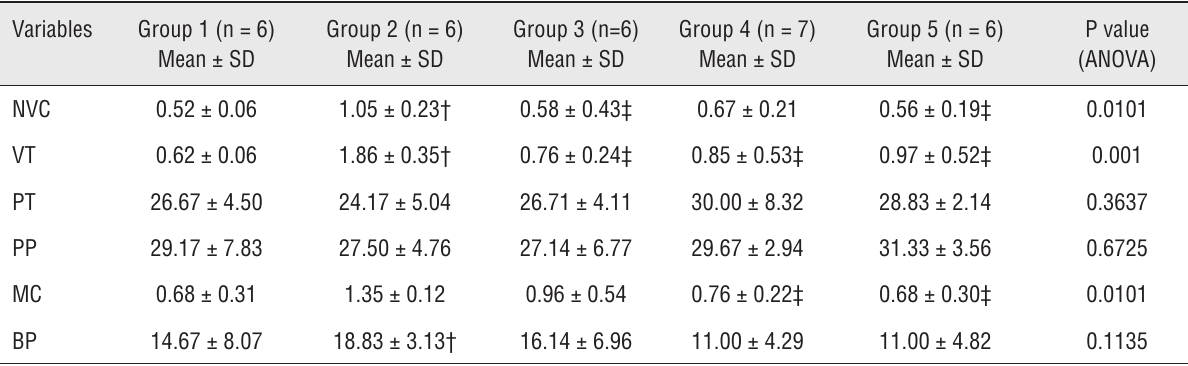
Table 1 - Administration of N ω -nitro- -arginine methyl ester hydrochloride (L-NAME) to the Group 2 resulted in increased L number of non voiding contractions, volume threshold and micturition cycles compared to control. Administration of tamsulosin significantly decreased the number of non voiding contractions and volume threshold. Tadalafil decreased the number of volume threshold and micturition cycles. The combination of tamsulosin with tadalafil reduces either variables (COMPARED TO